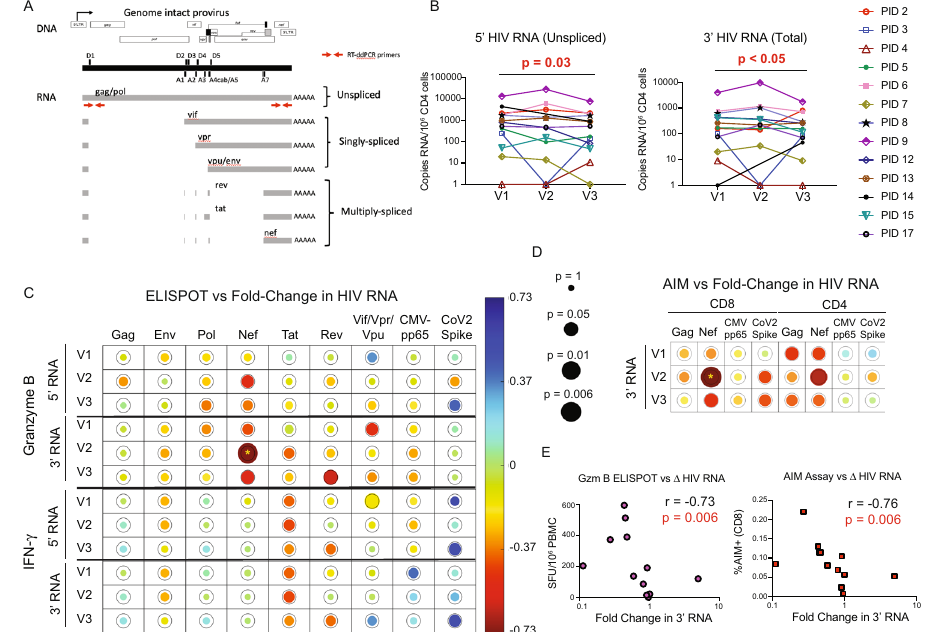
Fig. 5 | Cell-associated HIV RNA decreased across SARS-CoV-2 mRNA vaccina- tion, in inversely correlating with Gzm-B T-cell responses to early gene pro- ducts. A Positions of RT-qPCR primer/probes. The 3 ’ primer/probes target all unspliced and spliced isoforms of HIV poly(A) RNA, whereas the 5 ’ primer/probes only target unspliced. B Cell-associated HIV RNA for n =13 ART-treated donors at baseline(V1),and ∼ 2weeksaftervaccinedose1(V2)orvaccinedose2(V3).Pvalues were calculated by one-tailed Wilcoxon matched-pairs signed rank tests, compar- ingV1to V3, without adjustments for multiple testing. C , D Depiction of Spearman correlations between proportional changes (V3/V1) in HIV RNA and magnitudes of indicatedT-cellresponsesmeasuredatindicatedvisitsbyELISPOT( C )orAIMassay